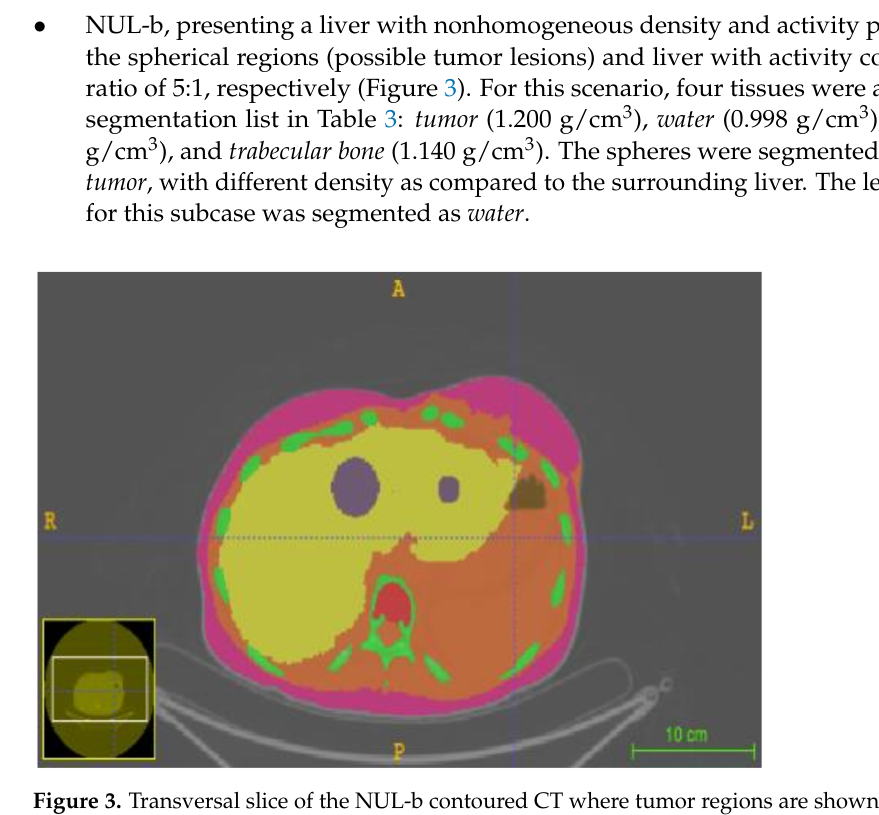
Figure 3. Transversal slice of the NUL-b contoured CT where tumor regions are shown in purple (BS and SS are visible in this